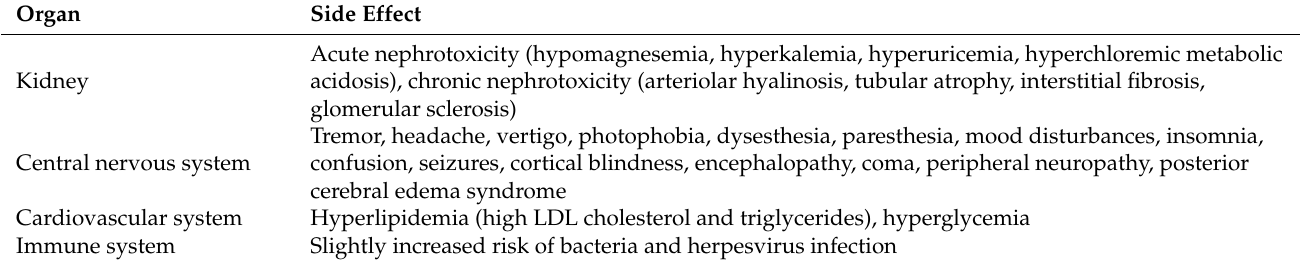
Table 6. Summary of Organ-Specific Side Effects of Tacrolimus